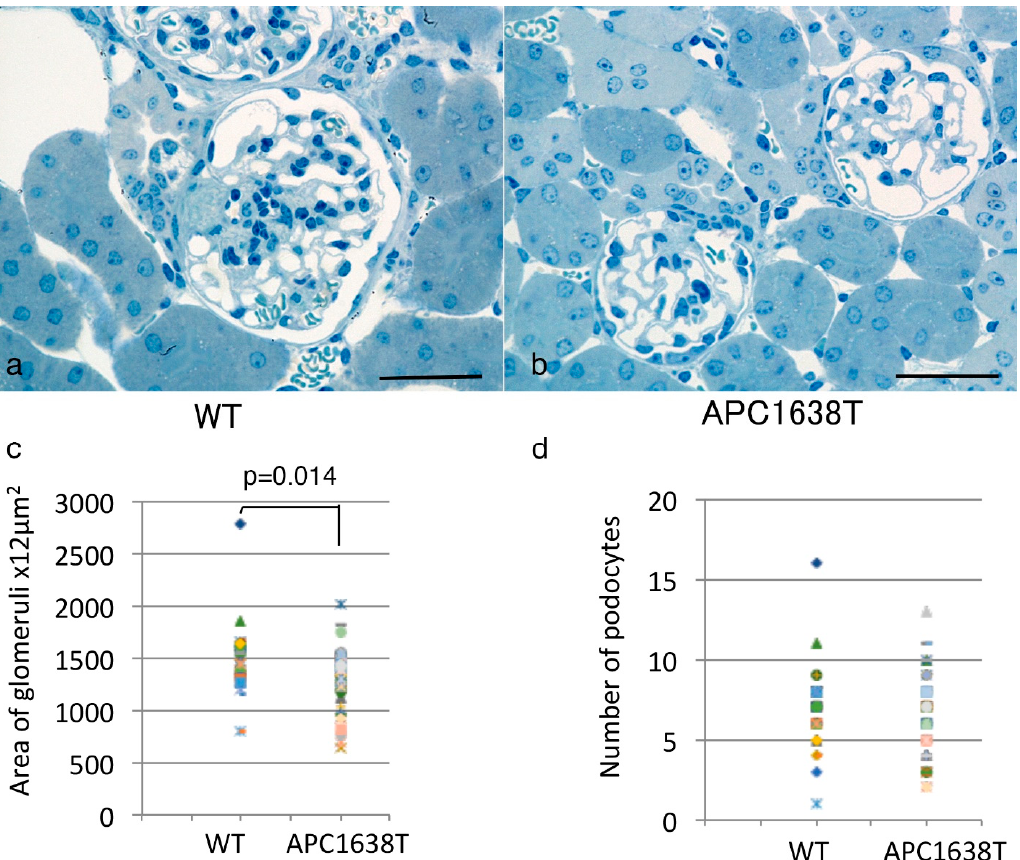
Figure 2. Toluidine blue staining of EPON-embedded renal sections from wild-type ( a ) and APC1638T mouse ( b ). The bars indicate 50 µ m ( a , b ). The area of glomerular tuft were measured using Image Pro software ( c ), and the number of podocytes ( d ) were measured by counting nucleus of podocyte in each glomerulus from a wild-type mouse (n = 32 glomeruli) and an APC1638T mouse (n = 51 glomeruli).